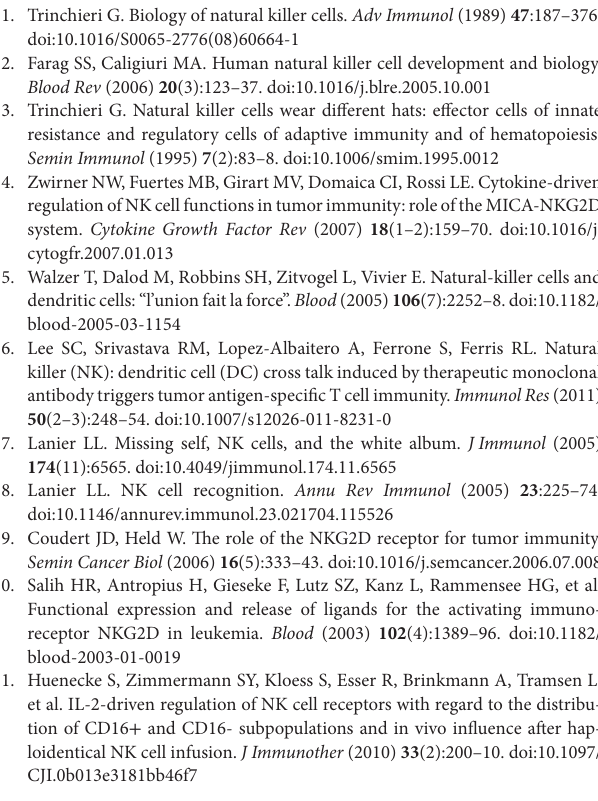
Figure s1 | gating strategy . Flow cytometry-based cytotoxicity assay of NK cells against singularized HNSCC cells. NK and HNSCC cells were stained with CD9 FITC, CD56 PC7, and CD45 KO mAbs. 7-AAD (7-amino-actinomycin D) was used to discriminate non-viable cells in FCM. Blue: CD45 + NK cells; red: CD9 + HNSSC cells; and grey: 7-AAD + effector and target cells. Dot plot areas were defined by the analysis of mono-cultured NK and HNSCC cells incubated for the identical time periods. Dot plot (WBC/MNC) displays an overview of all scatter events properties, and shows differentiations to non-specifically stained debris by low forward scatter signals. Plot (CAL) illustrates the events of the region “beads” along the time course to calibrate the events for “cells/ μ l” and detect even sample flow. Region (Target cells) is defined to include viable CD9 + HNSCC cells, and region (Effector cells) is defined to include all CD45 + NK cells. Plot (“Cell clusters”) represents the viable effector-target–cell interactions. Plot (“Viability”) is defined as a region to exclude the 7-AAD + cells. These 7-AAD + cells are not further presented in the following dot plots by using the characteristic signal when representing the 7-AAD fluorescence against the side scatter (SSC) properties.